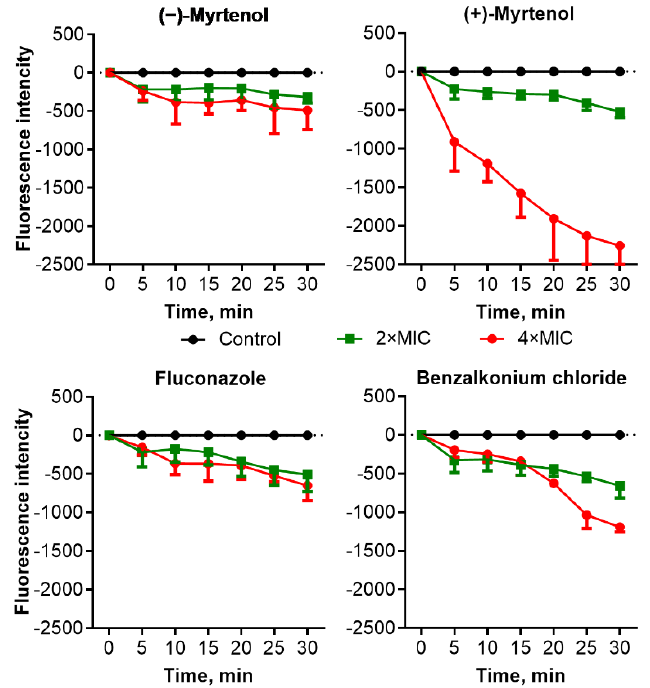
Figure 3. Relative membrane potential of C. albicans cells expressed in fluorescence units of DioC2(3) reduced on an intact cell membrane resulting in green fluorescence. Cells were grown for 18 h in Sabouraud broth, washed with PBS, and resuspended until a final density of 10 5 CFU/mL in PBS supplemented with DioC2(3) to a final concentration of 10 μM/mL. After a 30 min incubation at 25°C, compounds of interest were added to the samples. Fluorescence detection was performed for